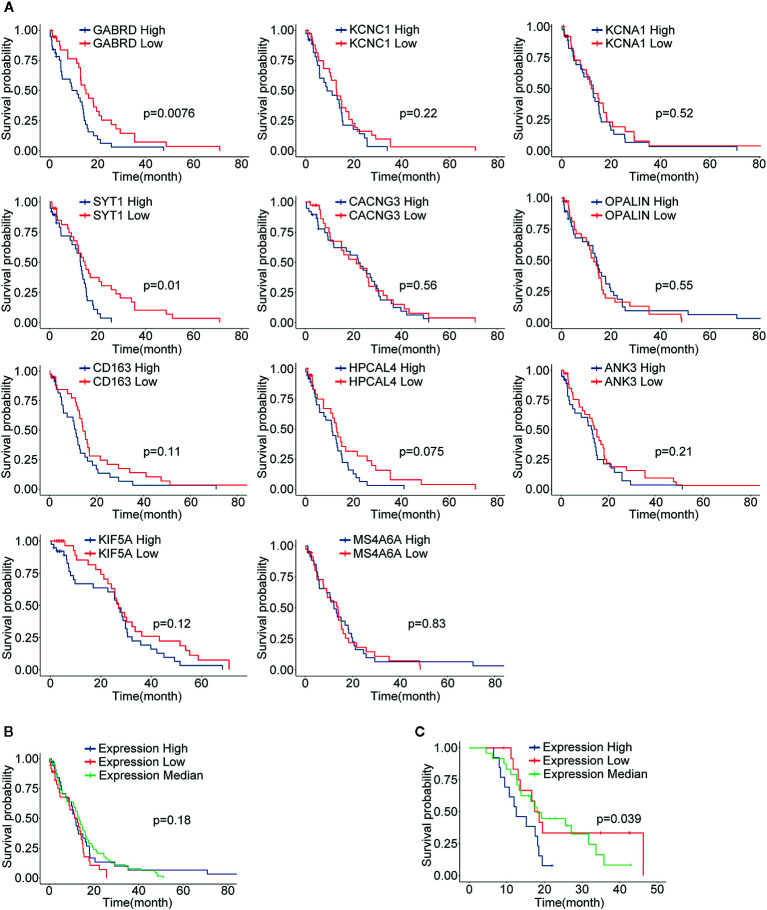
The results of survival analysis of core genes. (A) The relationship between the expression level of each gene and the GBM patient’s survival time, blue indicates the high expression group (N=77), red indicates the low expression group (N=77); (B) The survival curve and characteristic index of the core genes in the TCGA-GBM group vs. patient survival time; blue indicates the high expression group, red indicates the low expression group, and green indicates the intermediate expression group; (C) The results in validation dataset GSE83300, explained as in (B).